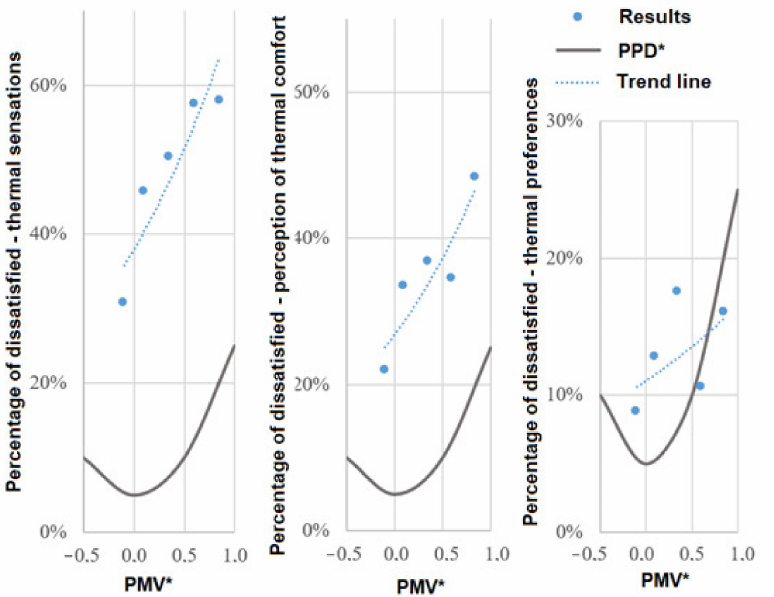
Figure 6. Actual vs. predicted percentage of dissatisfied patients—a comparative analysis of actual and predicted percentage with the adaptive model percentage of dissatisfied patients in different thermal conditions according to patients’ thermal sensations, thermal comfort feelings, and thermal preferences